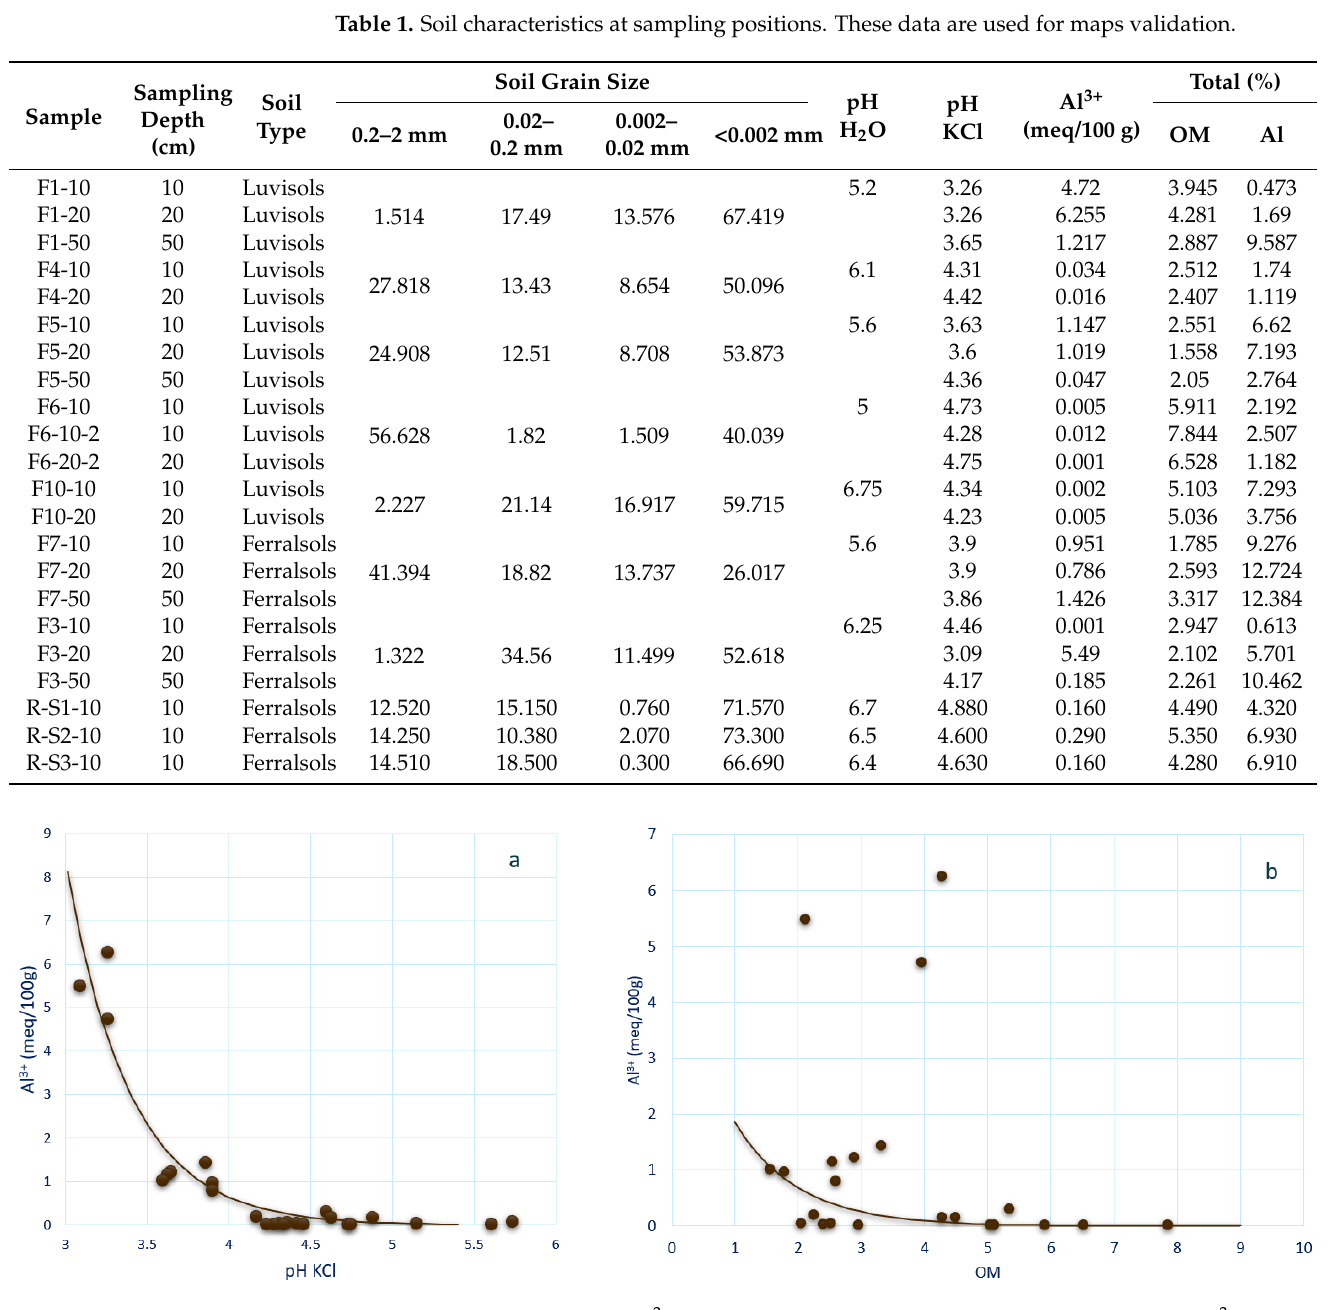
Figure 3. ( a ) Relationships of Al 3+ concentrations and soil pH and ( b ) Relationships of Al 3+ concen- trations and soil organic matter in the study area. Al 3+ concentration decreases following the gradient of soil pH and soil OM. The points are data, the values of which are shown in Table 1. Table 1. Soil characteristics at sampling positions. These data are used for maps validation.